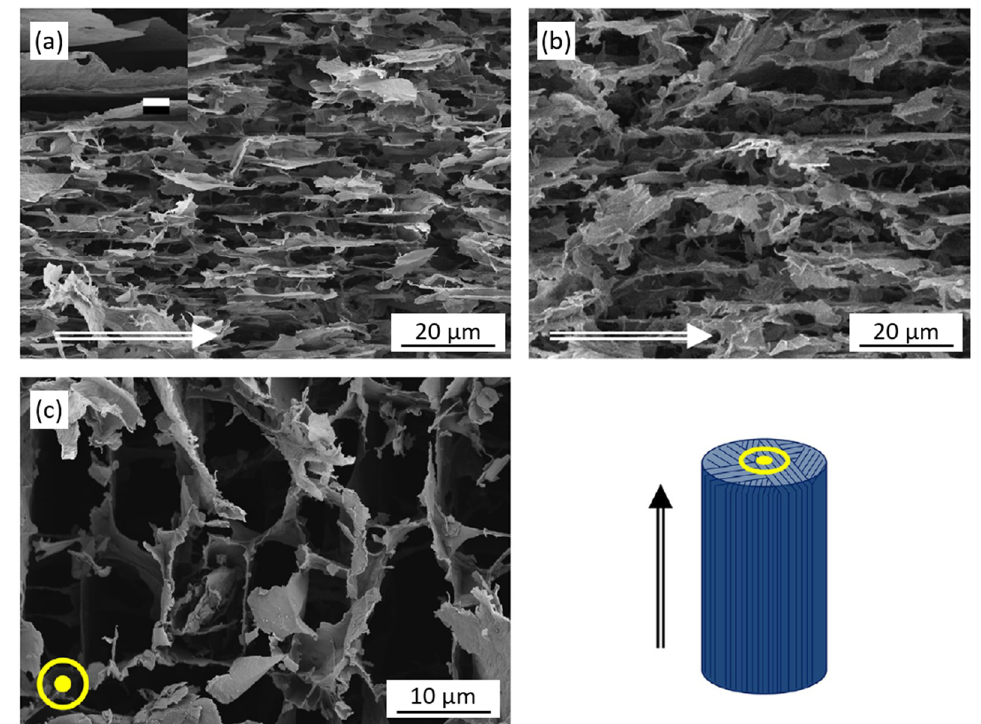
Figure 10. SEM micrographs showing the microstructures of CNF foams that were obtained after unidirectional freezing and sublimation. In figure ( a , b ), the CNF foam was cut parallel to the freezing direction (indicated by arrow), whereas in figure ( c ) the foam was cut perpendicular to the freezing direction. (Adapted from Donius et al. [136] with permission from Elsevier).